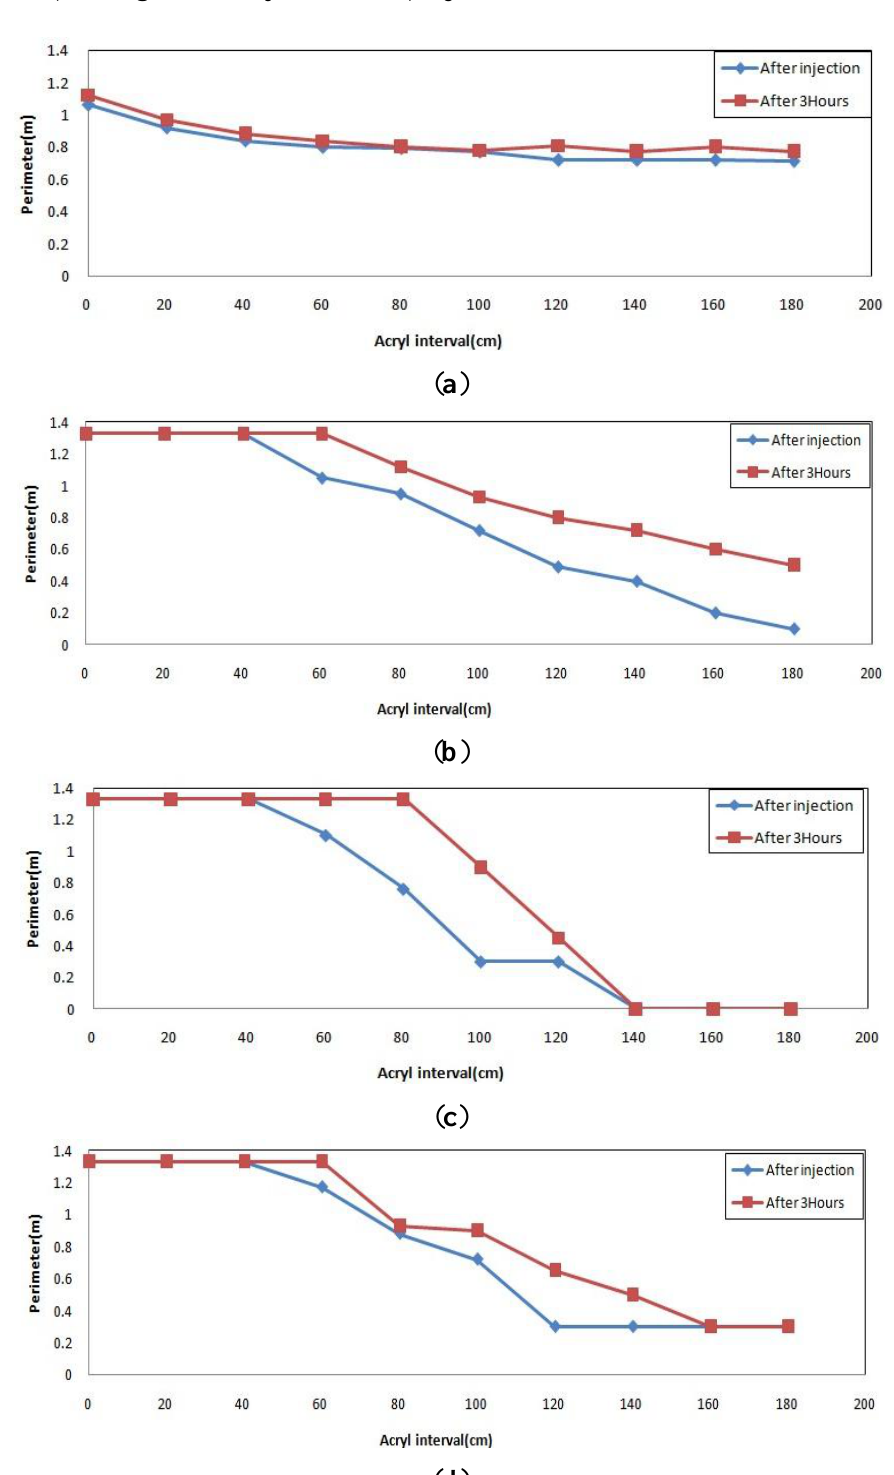
Figure 8. Injection pattern for quick-setting type material. ( a ) low viscosity (flow 0, injection 10); ( b ) low viscosity (flow 100, injection 10); ( c ) high viscosity (flow 0, injection 10); ( d ) high viscosity (flow 100, injection